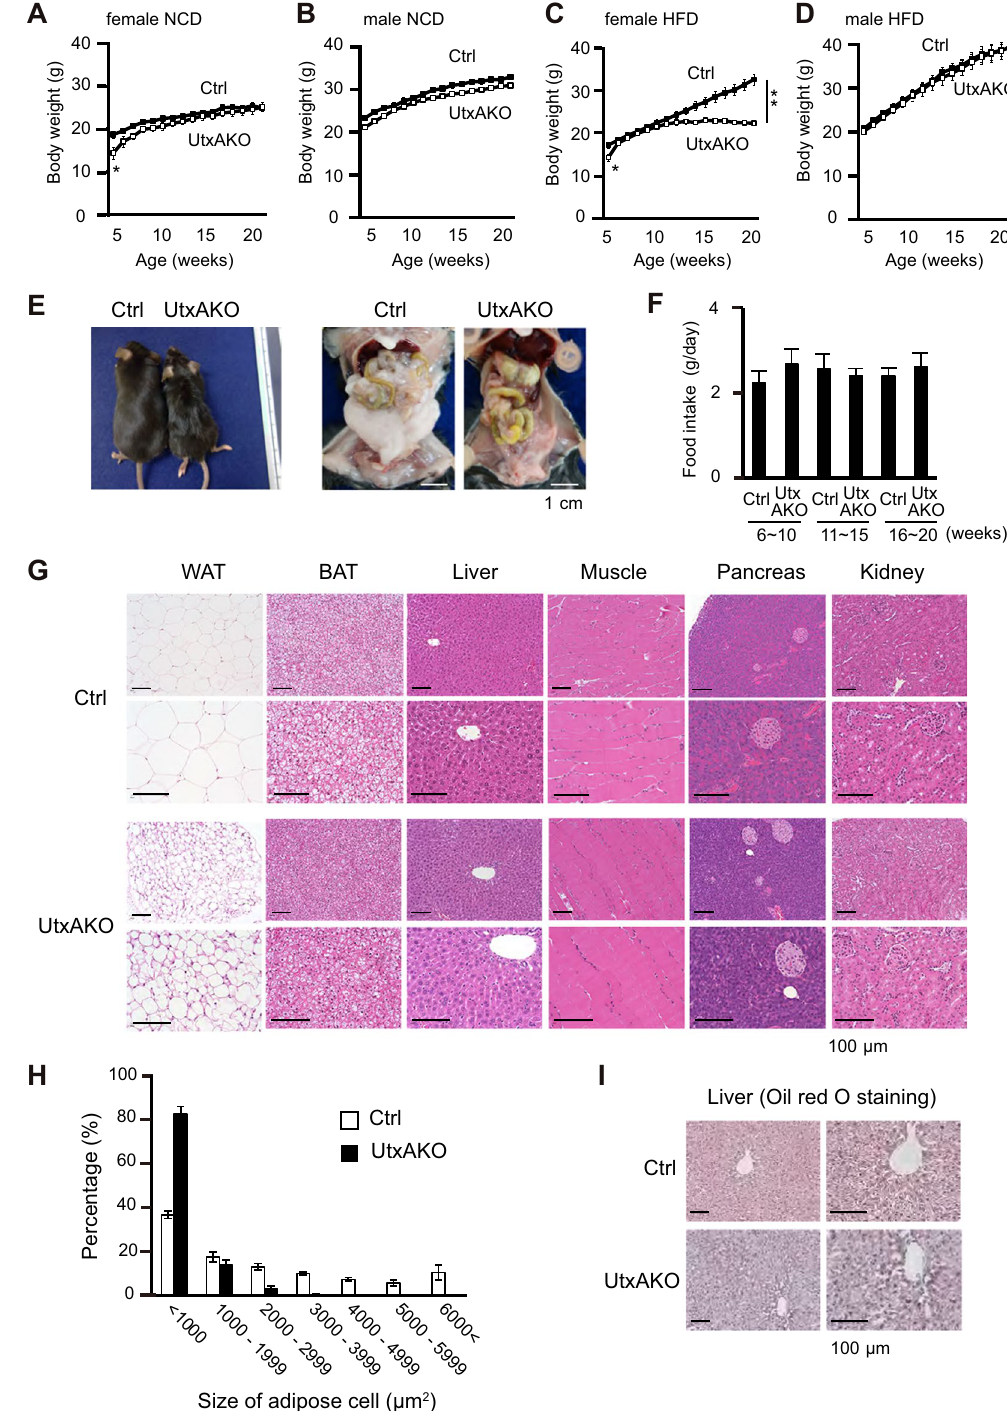
Figure 1. Female UtxAKO mice fed on a HFD show reduced adiposity. ( A – D ) Quantitation of change in body weight (BW) with time: ( A ) f-NCD-Ctrl vs. f-NCD-UtxAKO mice ( n = 5/group); ( B ) m-NCD-Ctrl vs. m-NCD-UtxAKO mice (Ctrl n = 4, UtxAKO n = 6); ( C ) f-HFD-Ctrl vs. f-HFD-UtxAKO mice (Ctrl n = 10, UtxAKO n = 8); ( D ) m-HFD-Ctrl vs. m-HFD-UtxAKO mice ( n = 5/group). ( E ) Left panel: Representative gross appearance of f-HFD-UtxAKO (right) and f-HFD-Ctrl (left) mice at 20 weeks of age. Middle panel: Increased visceral WAT (compared to f-NCD-Ctrl) in a f-HFD-Ctrl mouse at 20 weeks. Right panel: Decreased visceral WAT (compared to f-HFD-Ctrl) in a f-HFD-UtxAKO mouse at 20 weeks. Magnifications are shown (scale bars, 1 cm). ( F ) Quantitation of food intake by f-HFD-Ctrl vs. f-HFD-UtxAKO mice ( n = 7/group) at the indicated ages. ( G ) H&E staining of the indicated tissues of f-HFD-Ctrl vs. f-HFD-UtxAKO mice at 20 weeks. Two magnifications are shown (scale bars, 100 μ m). ( H ) Quantification of the lipid droplets with the indicated area size in visceral WAT of f-HFD-Ctrl vs. f-HFD-UtxAKO mice at 20 weeks (mean ± SD; n = 5/group). ( I